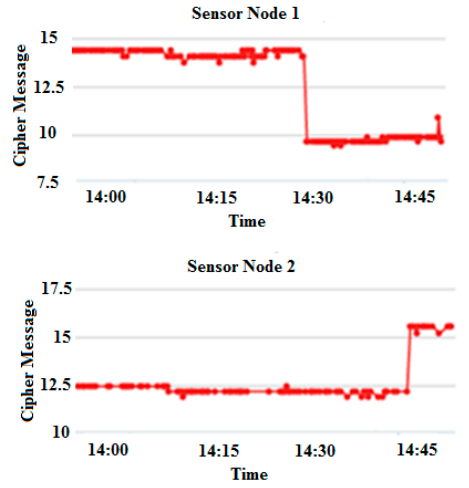
Figure 10. Cipher message from sensor node 1 and sensor node 2 by using proposed TBSA.